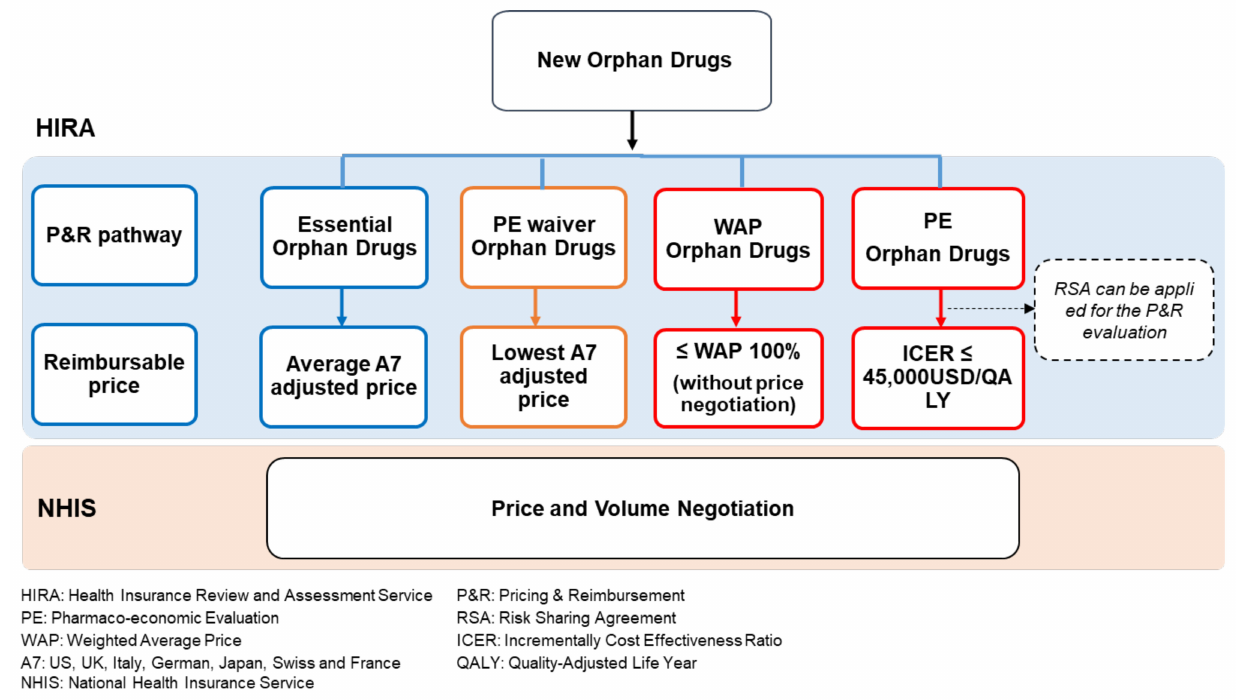
Figure 1. Four pathways for the pricing and reimbursement evaluation of new orphan drugs in the South Korean National Health Insurance